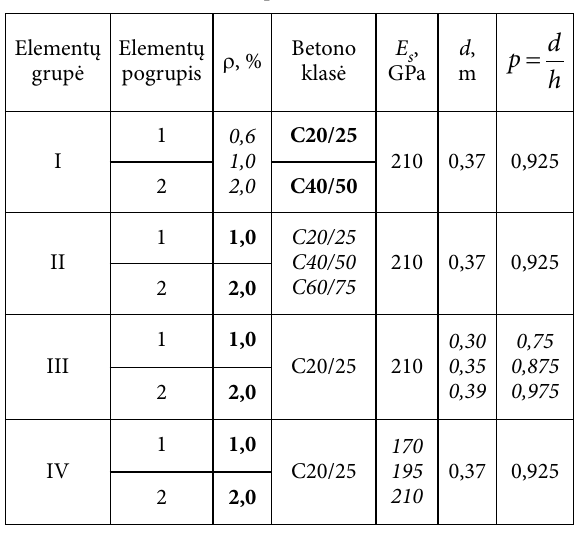
Table 1. The main parameters of RC beams Elementų grupė